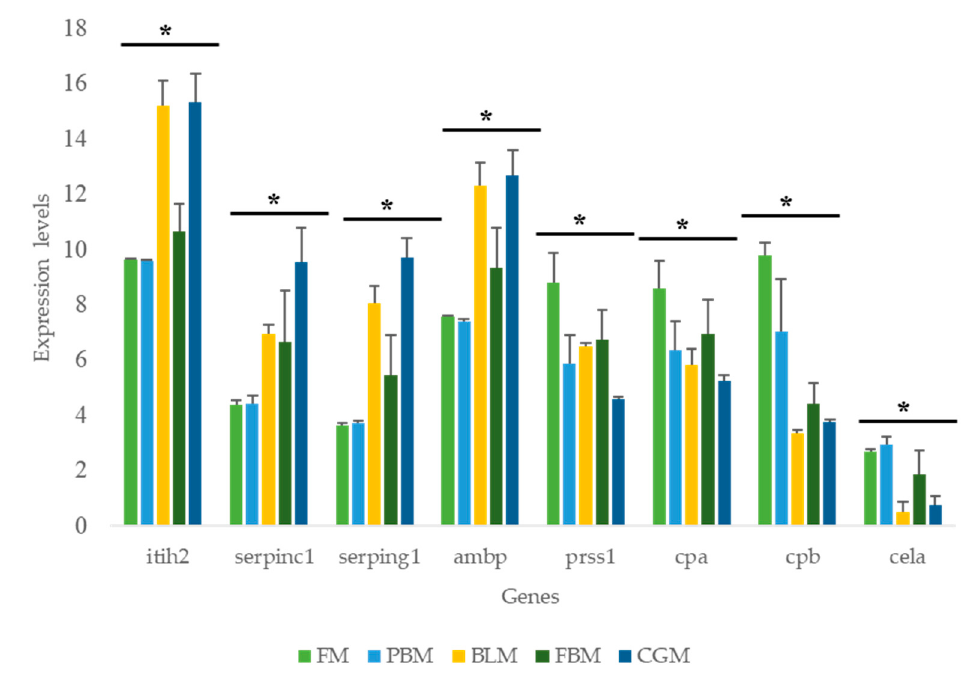
Figure 3. Expression levels of genes related to protein digestion in response to the different diets.